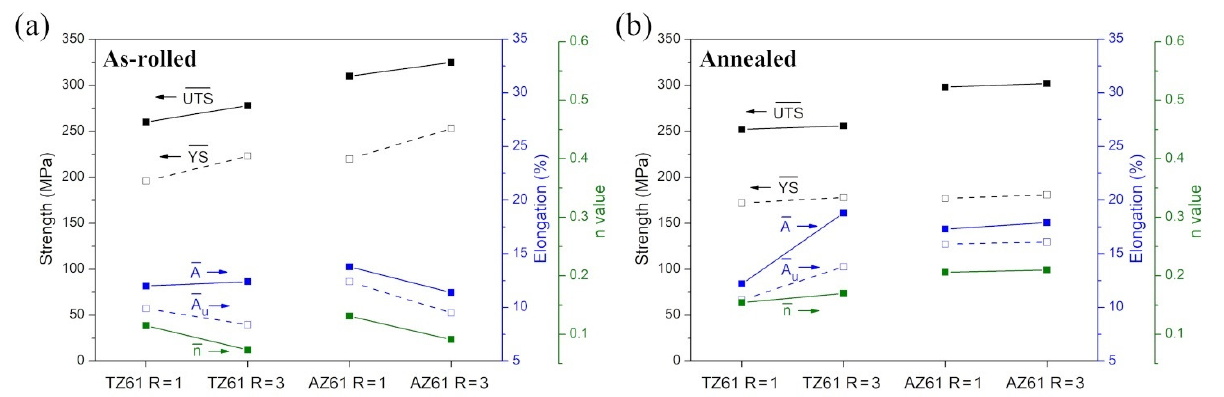
Figure 8. The average values of mechanical properties of the ( a ) as-rolled and ( b ) annealed TZ61 and AZ61 sheets processed at speed ratio R = 1 and 3.